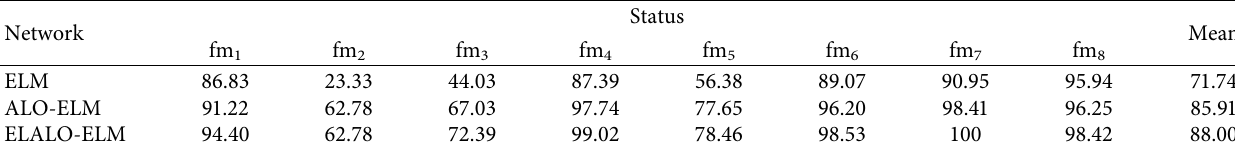
Table 6: Recognition rates comparison of 3